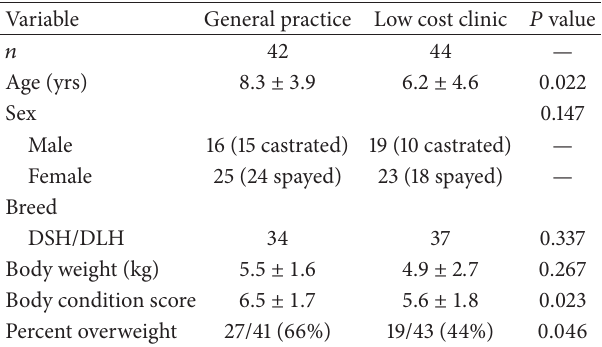
Table 3: Summary of cat demographic information from 86 cats enrolled from two veterinary clinics (absolute number or mean ± SD). Only breeds reported more than 5 times were included in the table. Variable